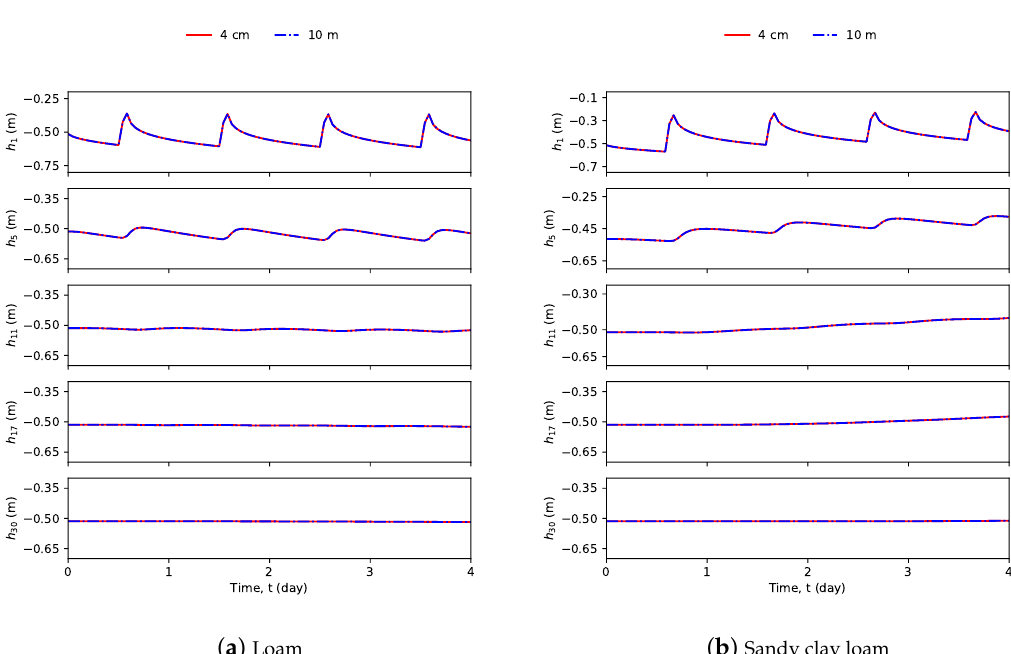
Figure A3. Comparison of selected trajectories of Model 1 (4 cm) and Model 2 (10 m) under Scenario 3.